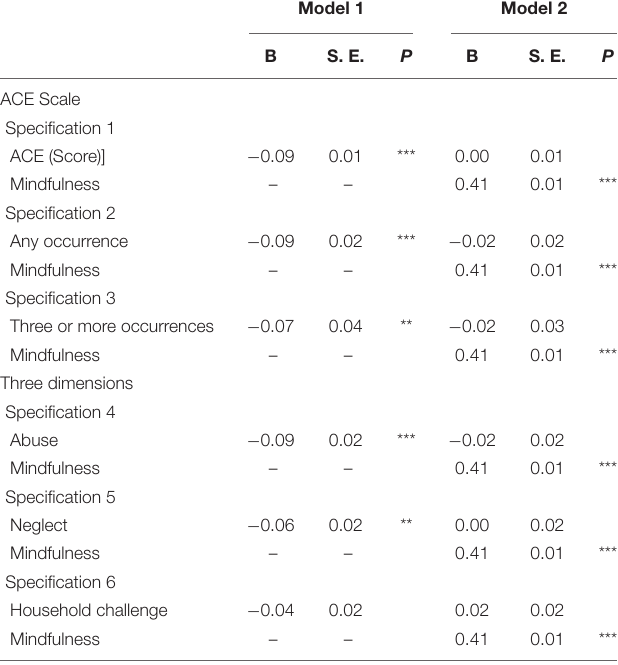
TABLE 4 | Robust tests of adverse childhood experiences (ACE) on grit.